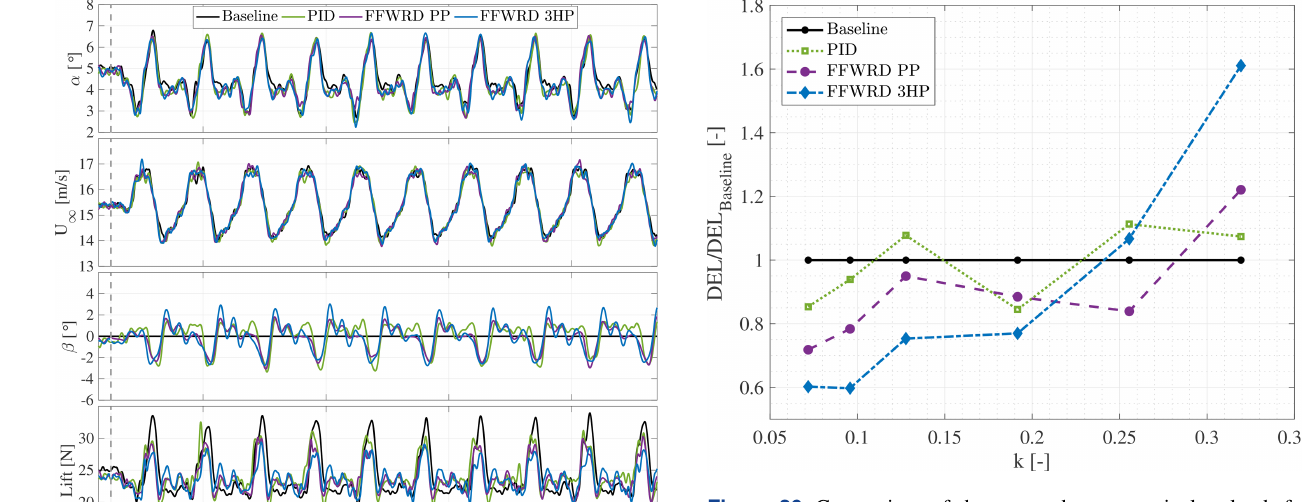
Figure 20. Comparison of short-term damage equivalent loads for feedforward and feedback